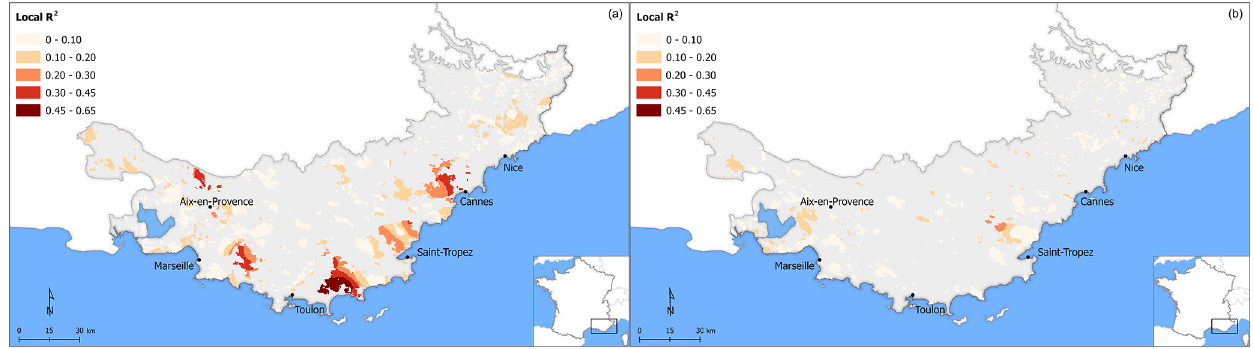
Figure 15. Spatial distribution of local R 2 between the burned area and slope inclination for 1970–1994 (a) and 1995–2019 (b) .